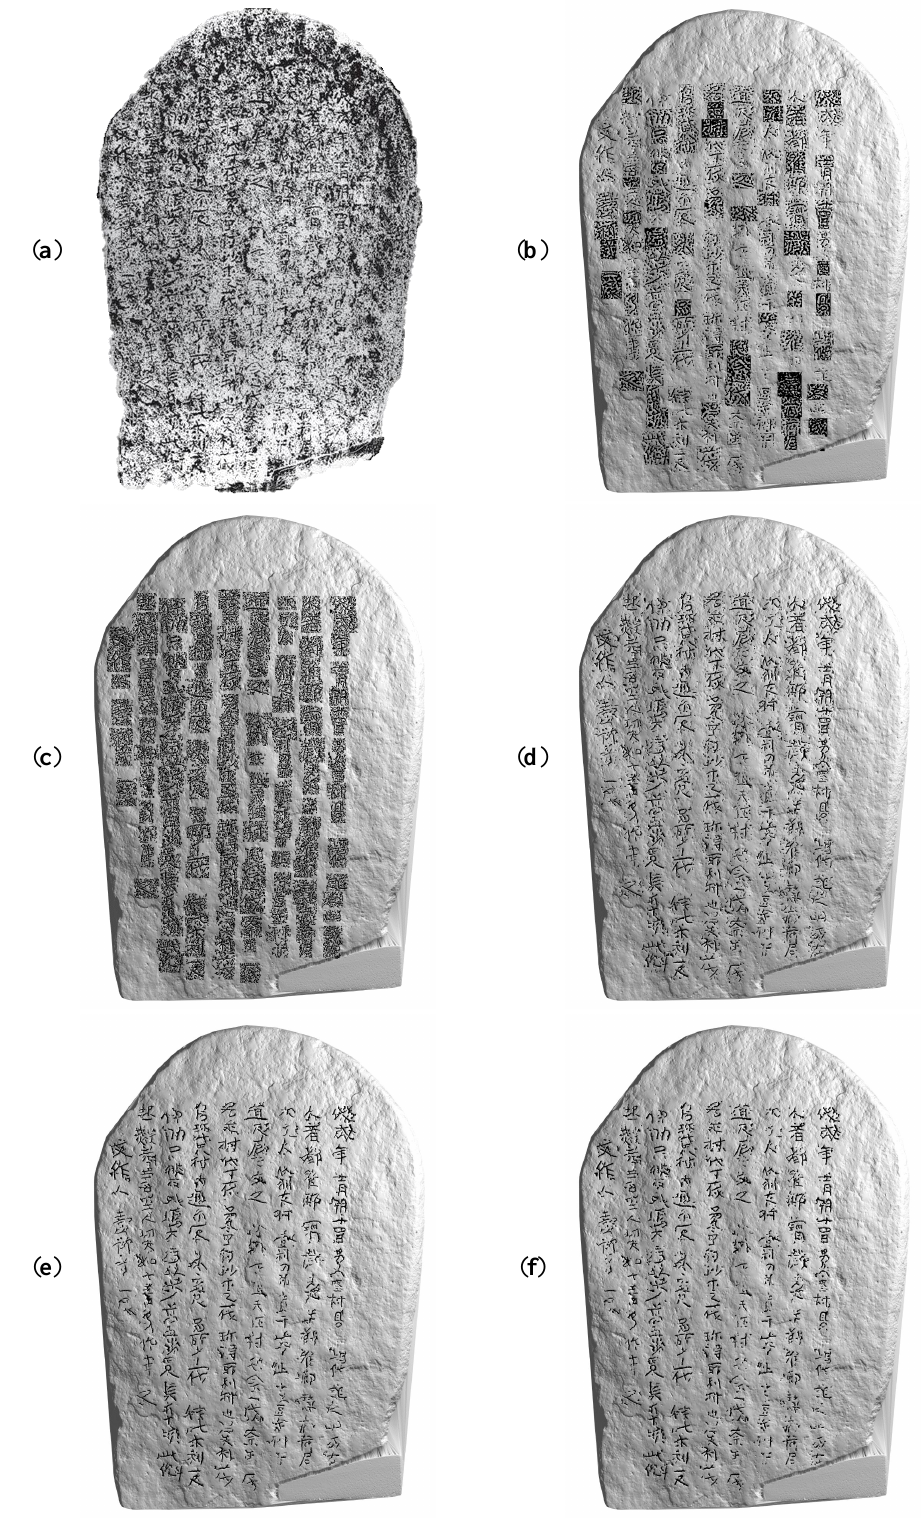
Figure 14. The comparison of the existing relief extraction methods and the proposed method: ( a ) stone rubbing; ( b ) the height-based method [8]; ( c ) the curvature-based method [7]; ( d ) the modified curvature-based method [18]; ( e ) the SVM-based method [24]; and ( f ) the proposed